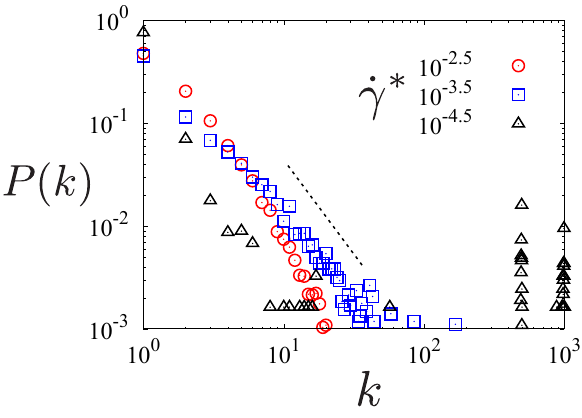
Figure 4. Fragment size distribution for ˙ γ ∗ = 10 − 2 . 5 (open circles), 10 − 3 . 5 (open squares), and 10 − 4 . 5 (open triangles) af- ter applying the shear strain γ = 5. The dotted line represents P ( k ) ∼ k − 11 / 6 .